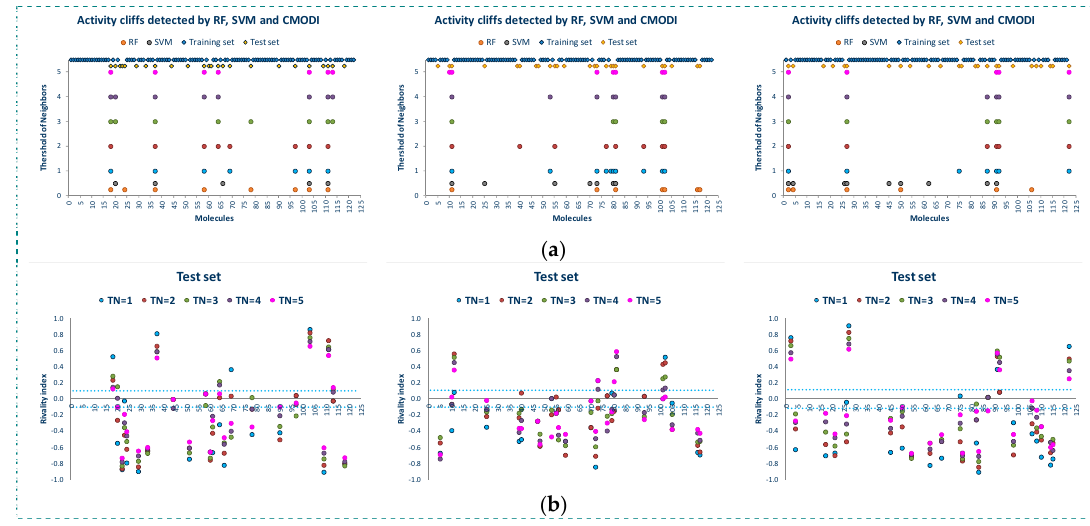
Figure 10. False positive/negative detected by RF and SVM algorithms and CMODI in the three external validations ( a ), rivality index values of the molecules of the external sets in the three external validations ( b ).